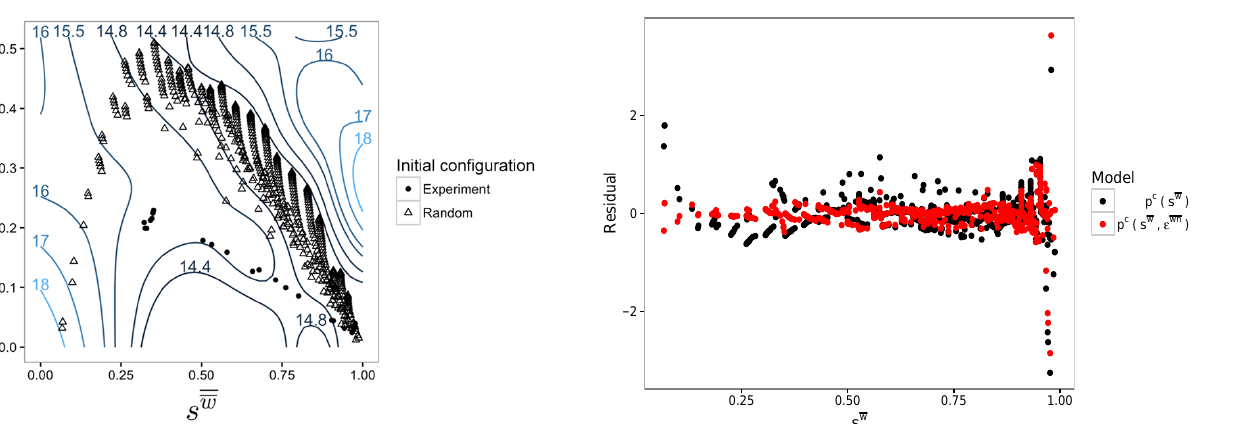
Figure 5. Comparison of the residual errors for the GAM fits that approximate p wn (s w ) and p wn (s w , (cid:15) wn )